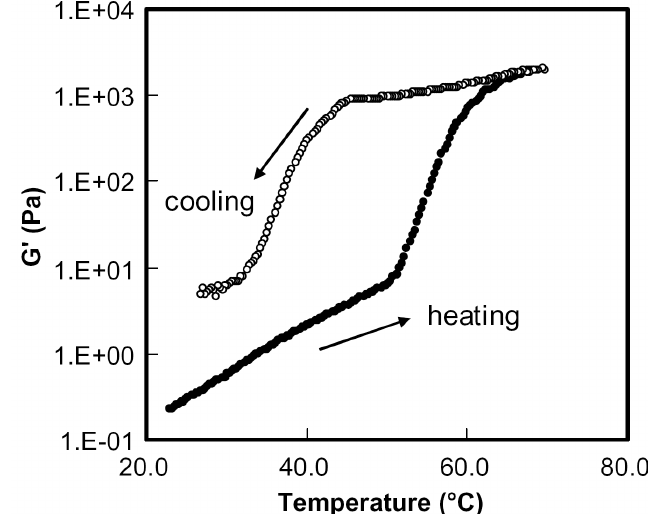
Figure 21. Dynamic storage modulus ' G of HPMC (10 wt%) in the presence of SIF (8.3 g/L) at a frequency x = 1 rad/s and a strain amplitude c = 5